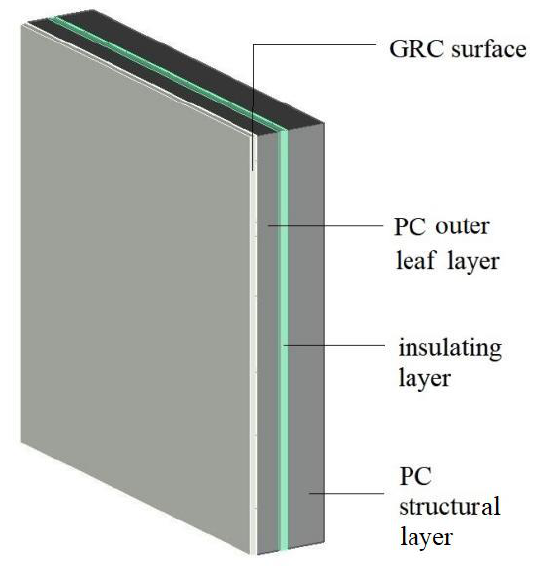
Figure 1. Schematic of a GRC-PC external wall structure.